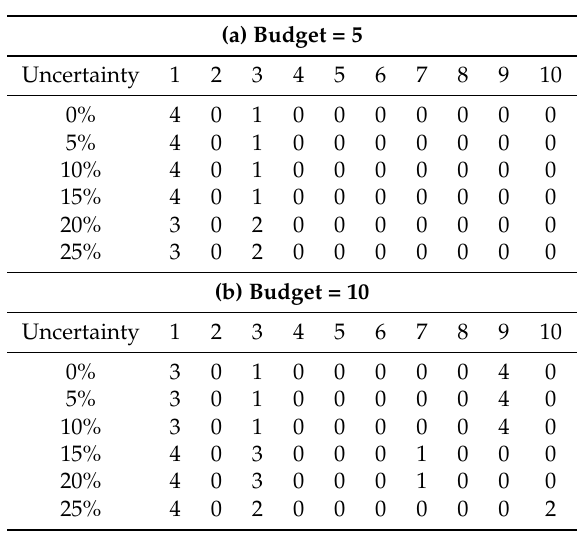
Table 1. Optimal